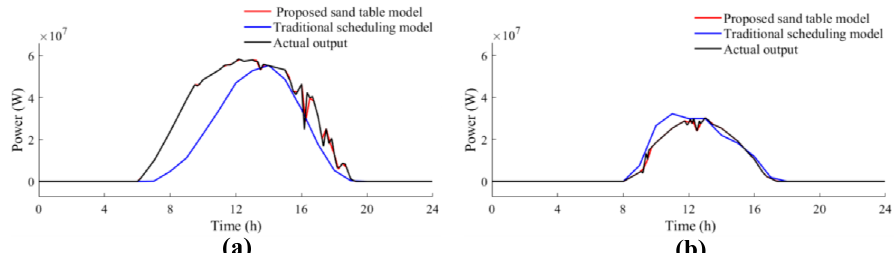
Figure 7. The deduced ultra-short-term prediction output of solar power model ( a ) typical summer day and ( b ) typical winter day.